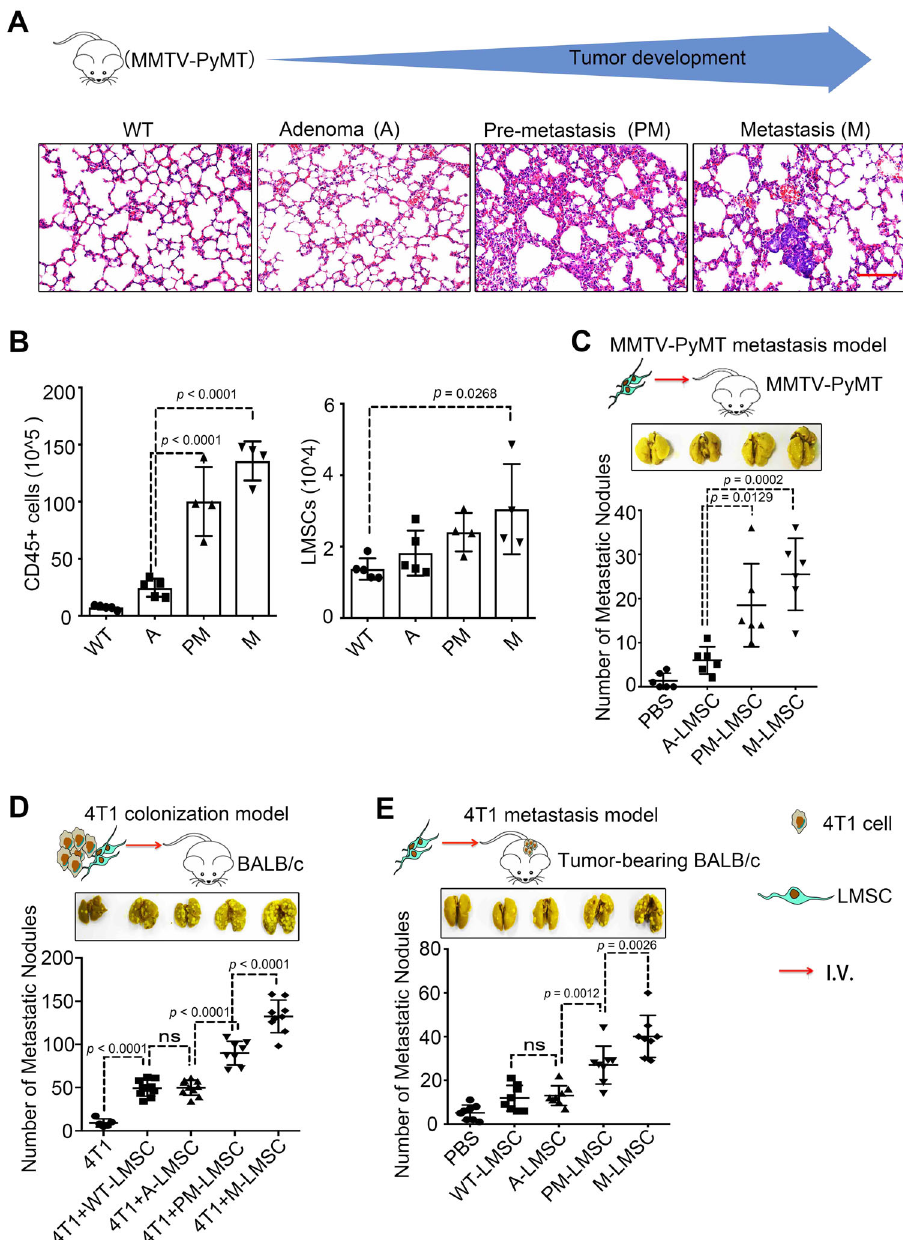
Fig. 1 LMSCs acquire increased metastasis-promoting ability along with tumor progression. A H&E staining of lung sections from MMTV-PyMT mice at different tumor stages, adenoma (A), pre-metastatic (PM), and metastatic (M) stage. Scale bar represents 100 μ m. The images were representative of those generated from fi ve mice in each group. B Single-cell suspensions prepared from lung tissues of MMTV-PyMT mice at various time points were enumerated and analyzed by fl ow cytometry for CD45 + immune cells and 7AAD − Lineage − Sca1 + CD44 + LMSCs. n = 5, 5, 4, and 4 mice. C PM- or M-LMSCs promote lung metastasis in MMTV-PyMT mice. PBS or A-, PM-, and M-LMSCs (1 × 10 5 ) were administered into MMTV-PyMT mice at the adenoma stage. Five weeks later, lung metastatic nodules (LMNs) were counted. n = 6 mice per group. D PM- or M-LMSCs promote lung colonization of intravenously injected 4T1 breast cancer cells. 4T1 cells were co-administered with WT-LMSCs from FVB or A-, PM-, and M-LMSCs from MMTV-PyMT mice at a 1 : 5 ratio (1 × 10 4 LMSCs and 5 × 10 4 4T1 cells) into BALB/c mice by intravenous injection. After 14 days, LMNs were counted. From left to right: n = 5, 10, 10, 8, and 9 mice. E PM- or M-LMSCs promote lung metastasis of 4T1 cells implanted in fat pad. 4T1 cells (4 × 10 5 ) were implanted into fat pads of BALB/c mice. After 10 days, WT-LMSCs or A-, PM-, and M-LMSCs (1 × 10 5 ) were injected into these tumor-bearing mice by intravenous injection, respectively. LMNs were counted on day 30. n = 8 mice per group. All the data are presented as mean values ± SD. ns, not signi fi cant; p < 0.05, signi fi cant, using a one-way ANOVA with Sidak ’ s post test. Source data are provided as a Source Data fi le for Fig. 1B – E.